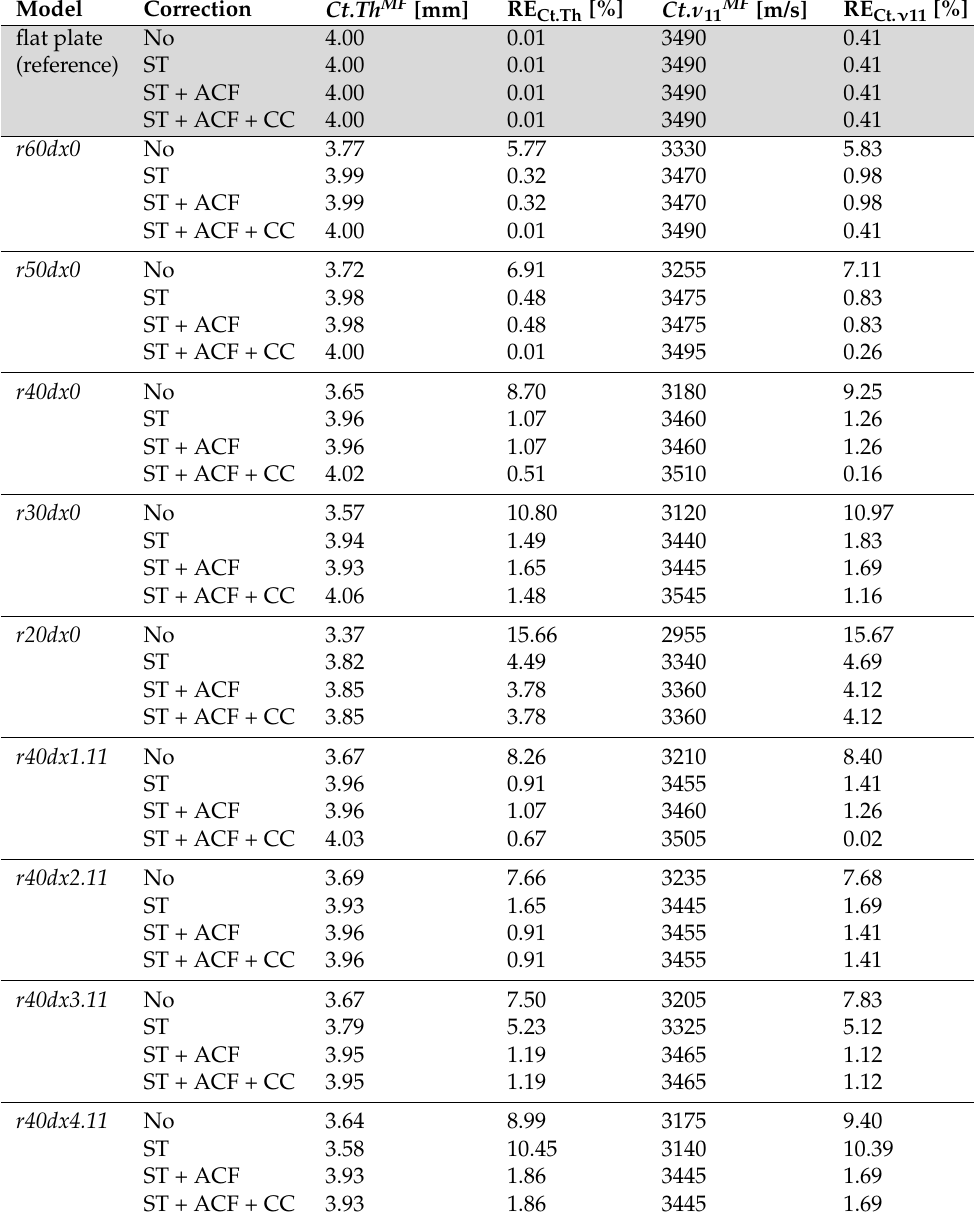
Table A4. Results of Ct . Th MF , Ct . ν 11 MF and relative errors (RE) for each PAC method.